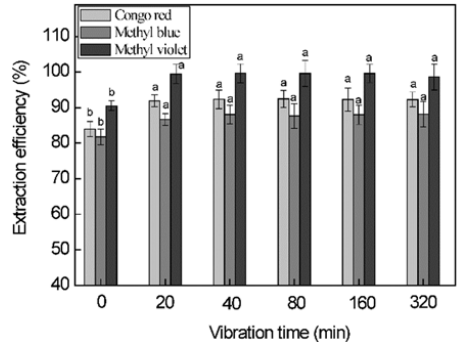
Figure 6. Effect of the vibration time on the extraction efficiency of the dyes. (Each system contained 10 mL dyes solution (1 mg/mL CR, MB and 0.125 mg/mL MV), 4 mg Fe 3 O 4 @NH 2 , 4 wt. % TX ‐ 114, and incubated at temperature 40 °C for 10 min). Different letters in the same series indicate significant difference at p < 0.05 level.